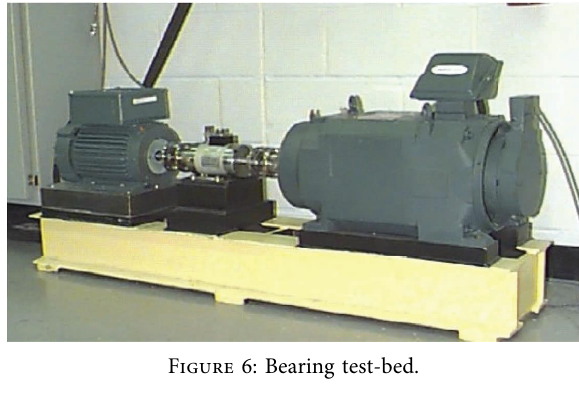
Figure 6: Bearing test-bed.